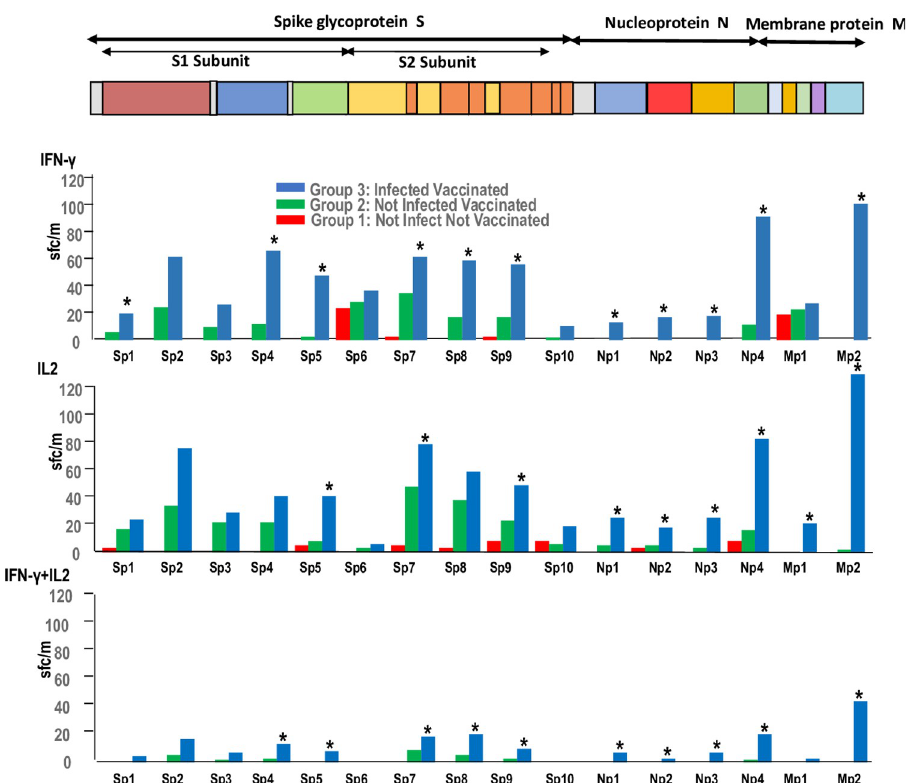
Fig 2. Group 1, Group 2, and Group 3: Median IFN- γ , IL2, and IFN- γ +IL2 responses to S, N, and M subpools. Medians of the magnitudes of responses of Group 1 (uninfected, unvaccinated), Group 2 (uninfected, vaccinated), and Group 3 (infected, vaccinated) IFN- γ , IL2, and IFN- γ +IL2 responses (spot forming cells/million PBMCs, sfc/m) to S glycoprotein (Sp1 –Sp10), N protein (Np1 –Np4), and M protein (Mp1, Mp2) peptide subpools. � Significant differences between Group 2 and Group 3 indicate that prior SARS-CoV-2 infection significantly increased responses to each subpool as indicated.